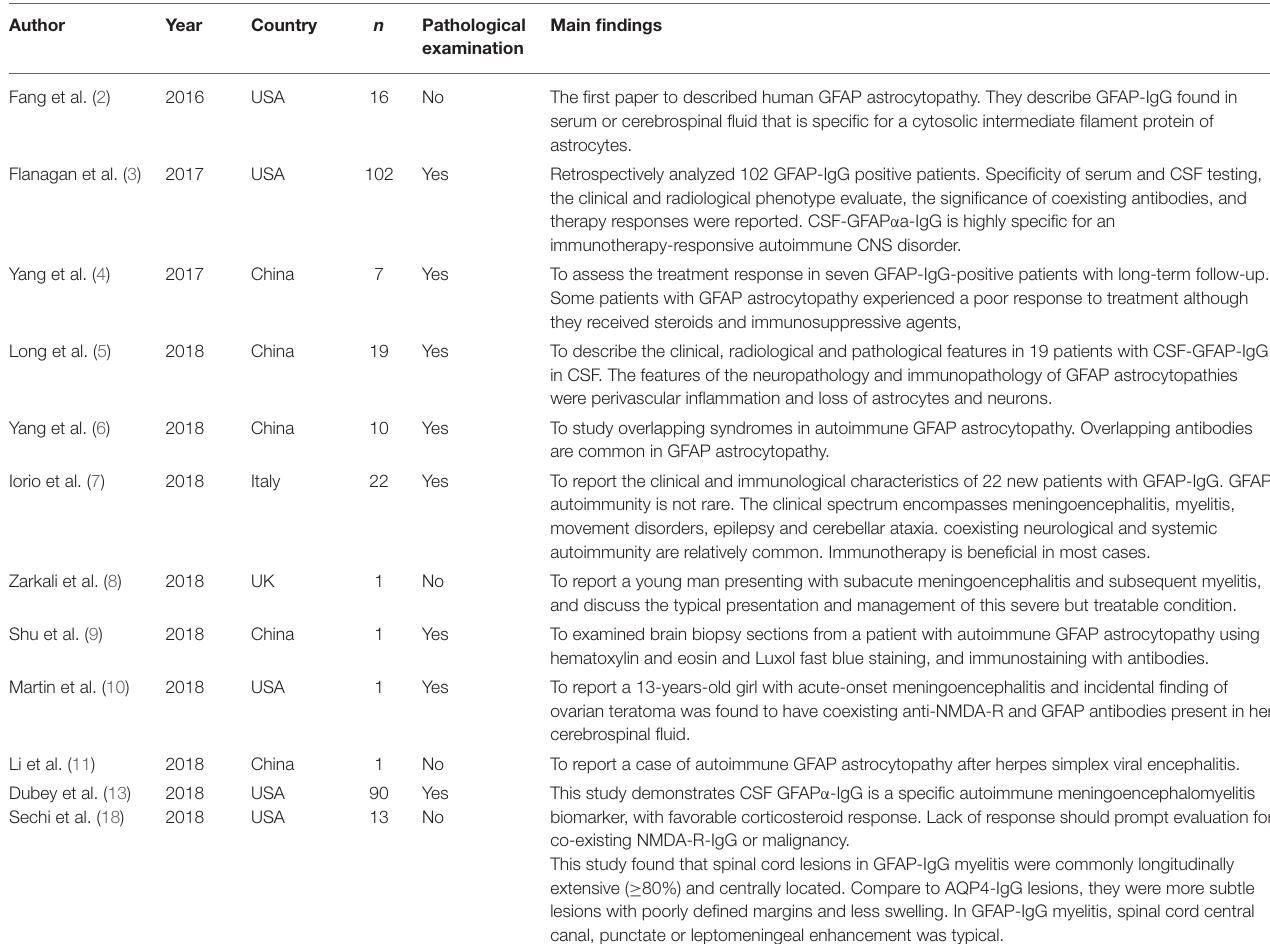
TABLE 1 | Literatures of human GFAP